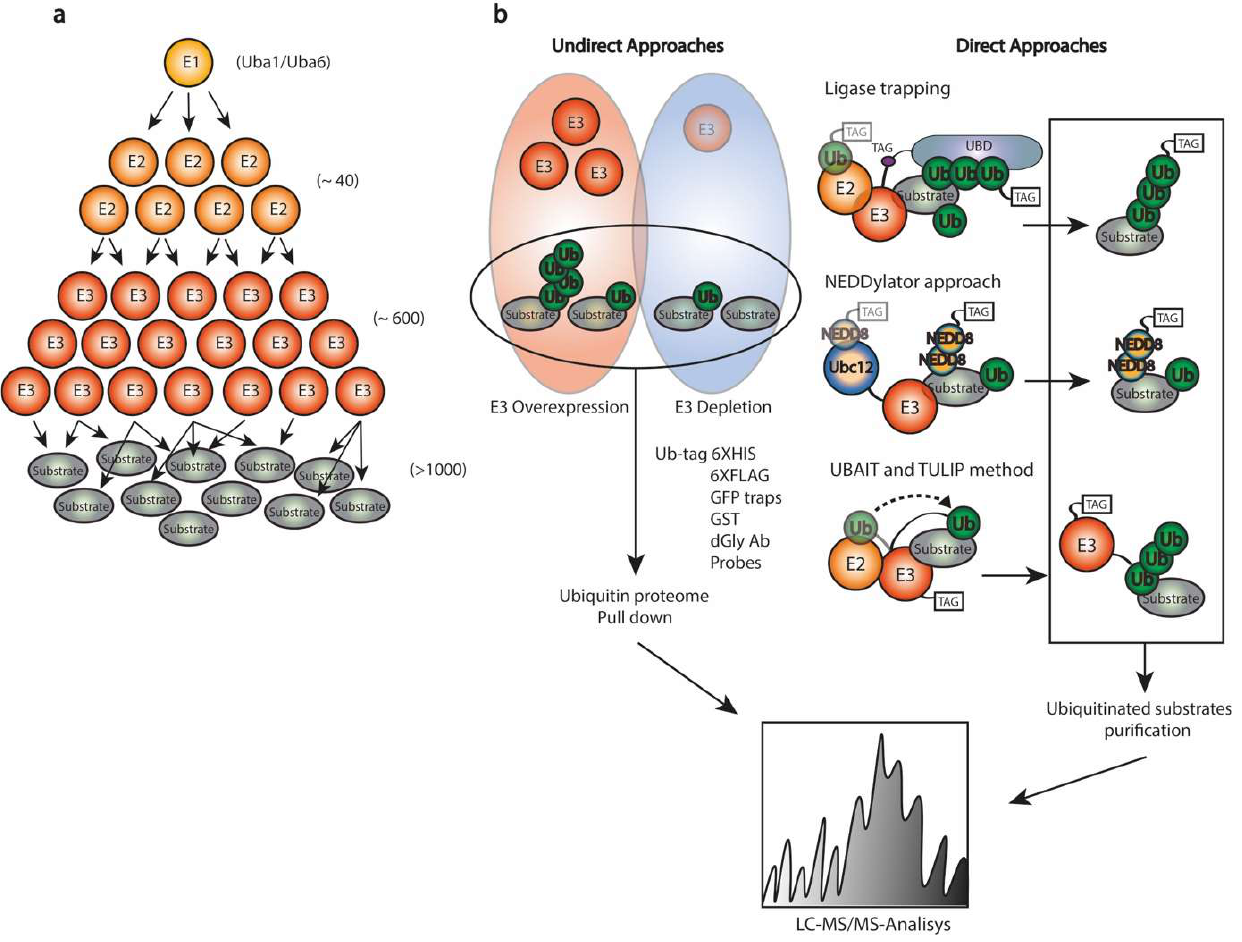
Figure 6. Proteomics for E3 ligase target identification. ( a ) Hierarchical organization of the ubiquitination cascade. Emphasizing the difficulty of mapping substrate proteins for specific E3 enzymes. ( b ) Strategies for E3 ligase substrate identification divided into undirect and direct approaches. Within undirect methods, in red, the overexpression of an E3 ligase results in the increase in ubiquitination levels for putative substrates. Opposing, in blue, the depletion of an E3 ligase displays a decrease in ubiquitination levels of putative substrates. The direct approaches allow identification of specific-E3 ligase substrates where ligase trapping, NEDDylation approach, and UBAIT/TULIP methodology are shown.